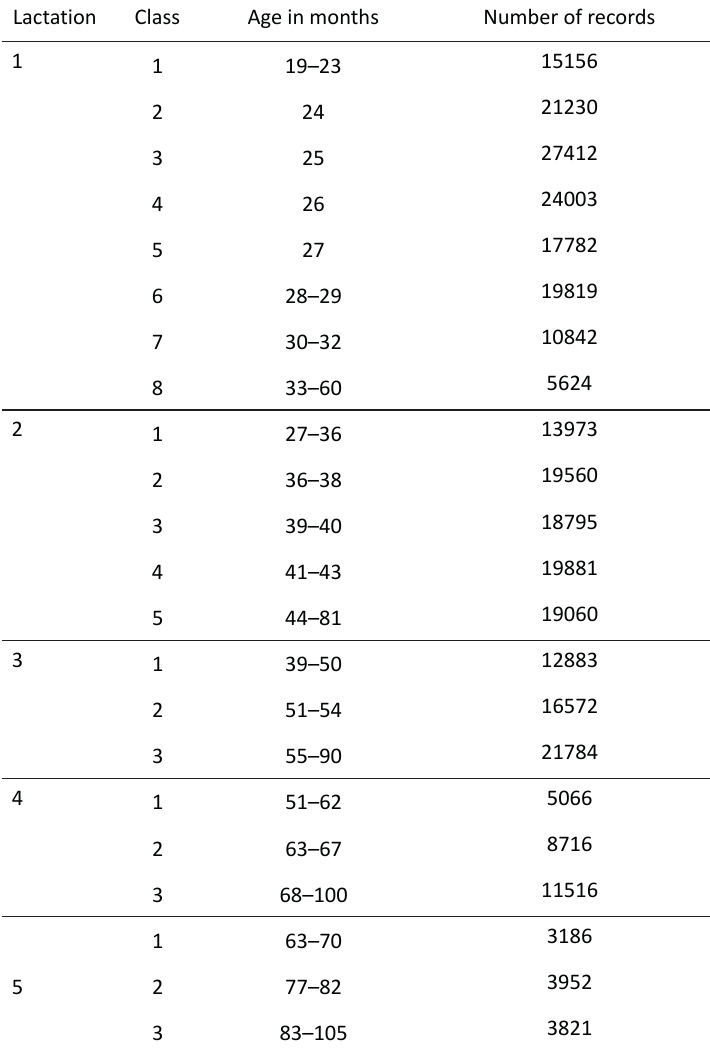
Table 4. Number of records in different age of calving classes and lactations Lactation